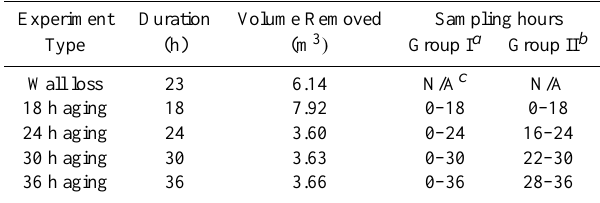
Table 1. Experiment sampling conditions and instrument sampling